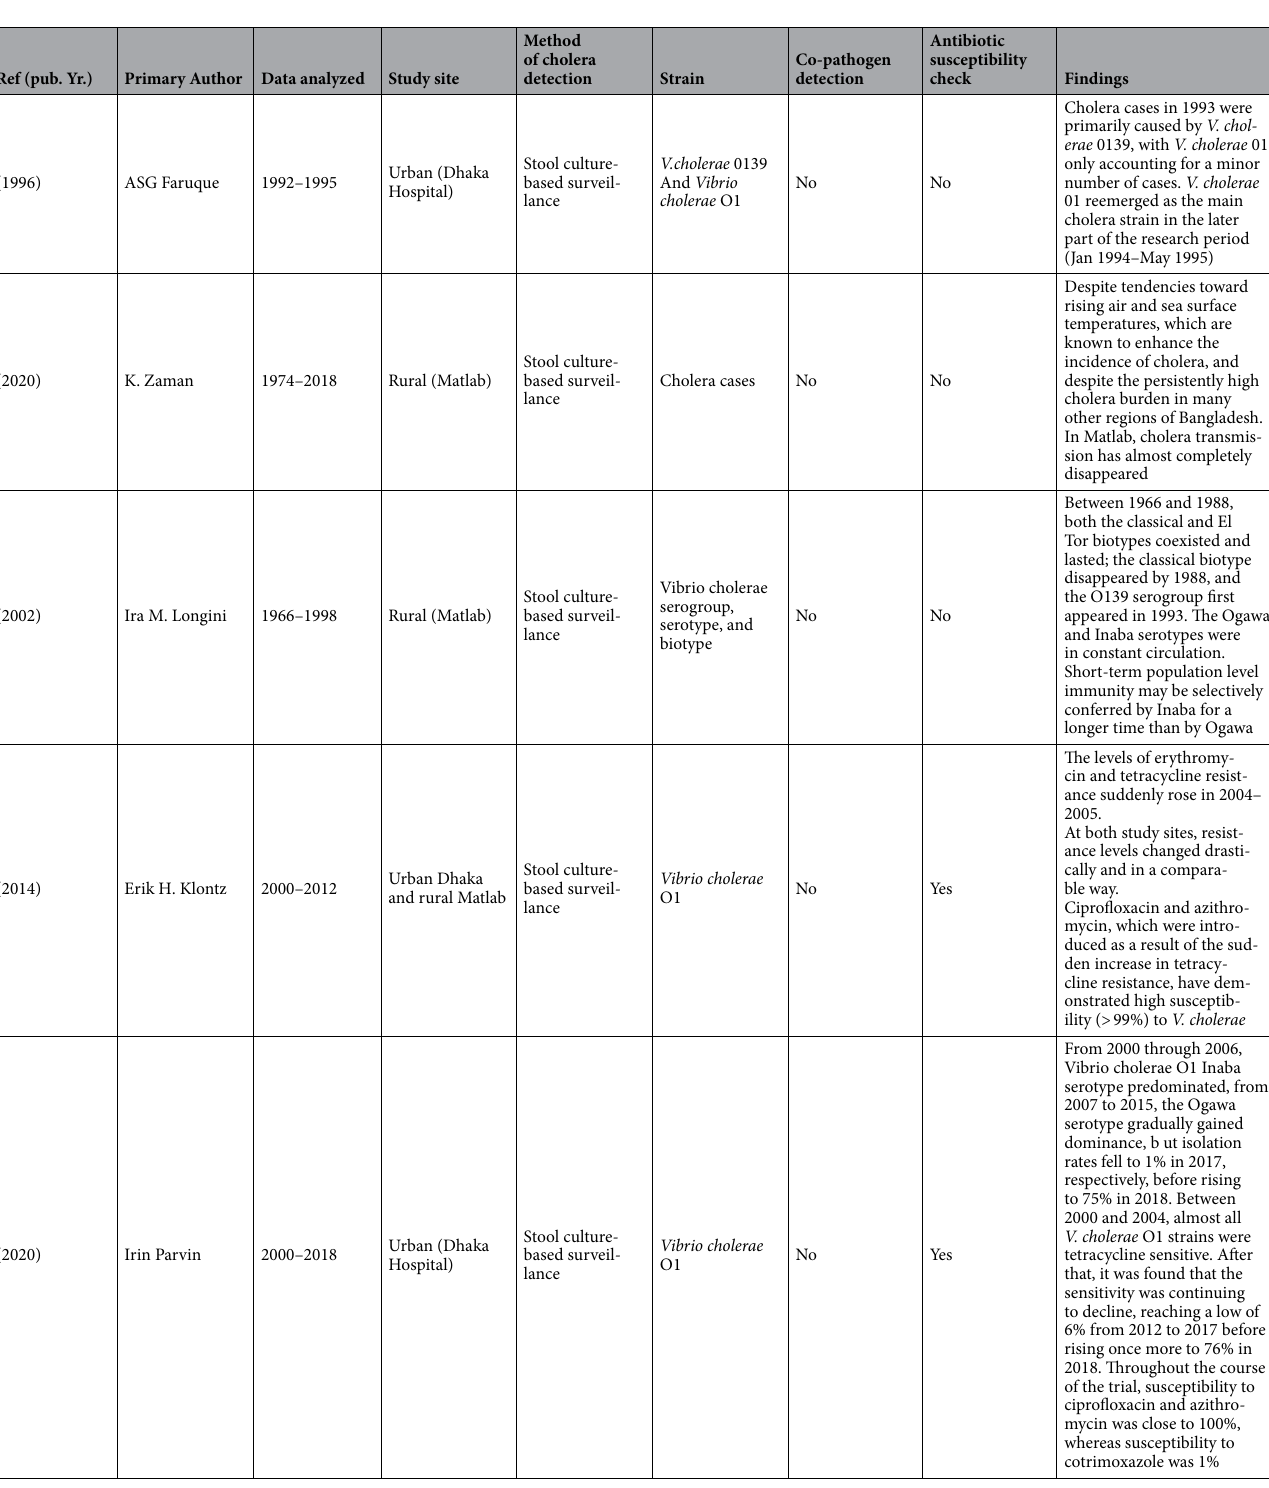
Table 4. Findings of articles on V. cholera trends from urban and rural